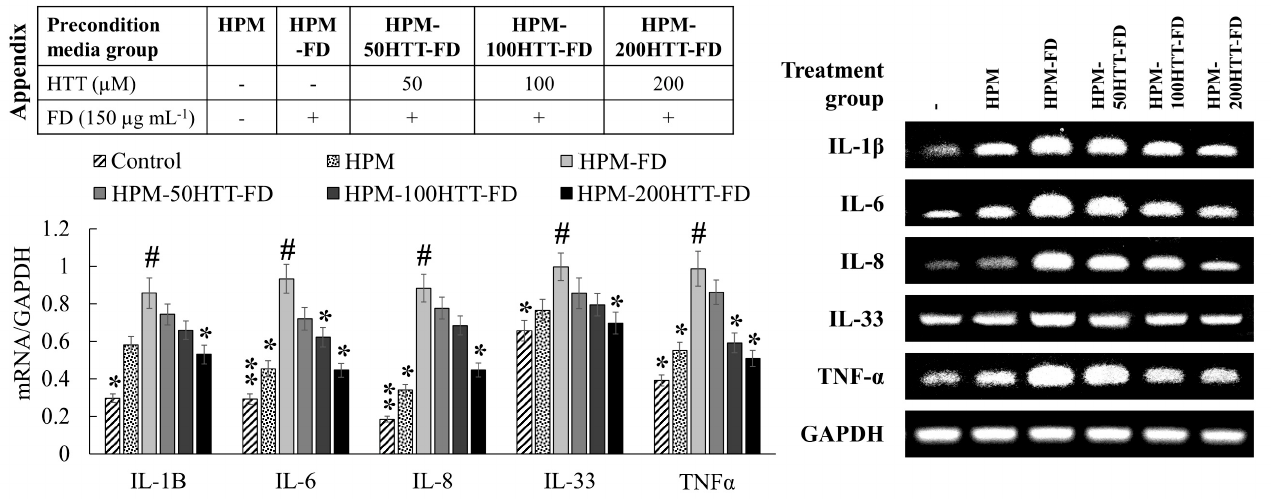
Figure 4. Effect of HTT priming in FD-stimulated HaCaT keratinocyte preconditioned media on inflammatory cytokine expression by integrated HDFs. Evaluations were carried out in triplicates ( n = 3) and indicated as means ± SD. “*” and “**” respectively denote p < 0.05 and p < 0.01 if they are significantly different from those of HPM-FD treated HDFs “#”.